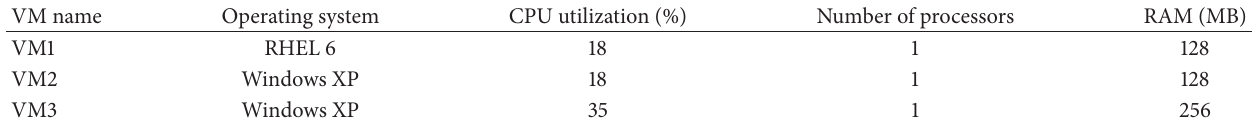
Table 12: Local list of node 3 (S1).